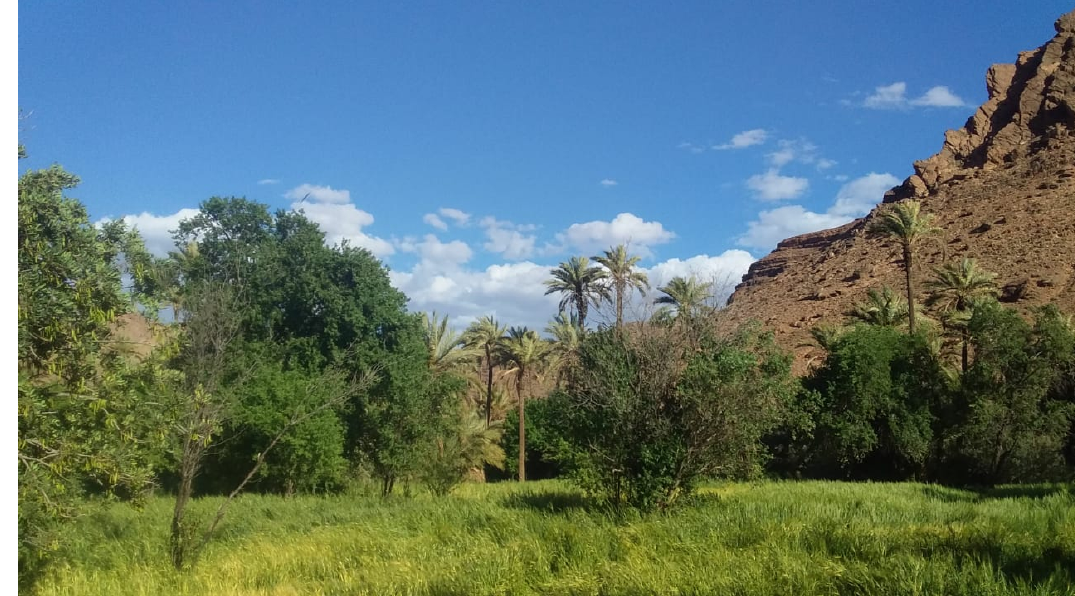
Figure 8. Example of cultural practice with date palm, fruit trees (olive, carob and pomegranate) and wheat, planted in the same plot.